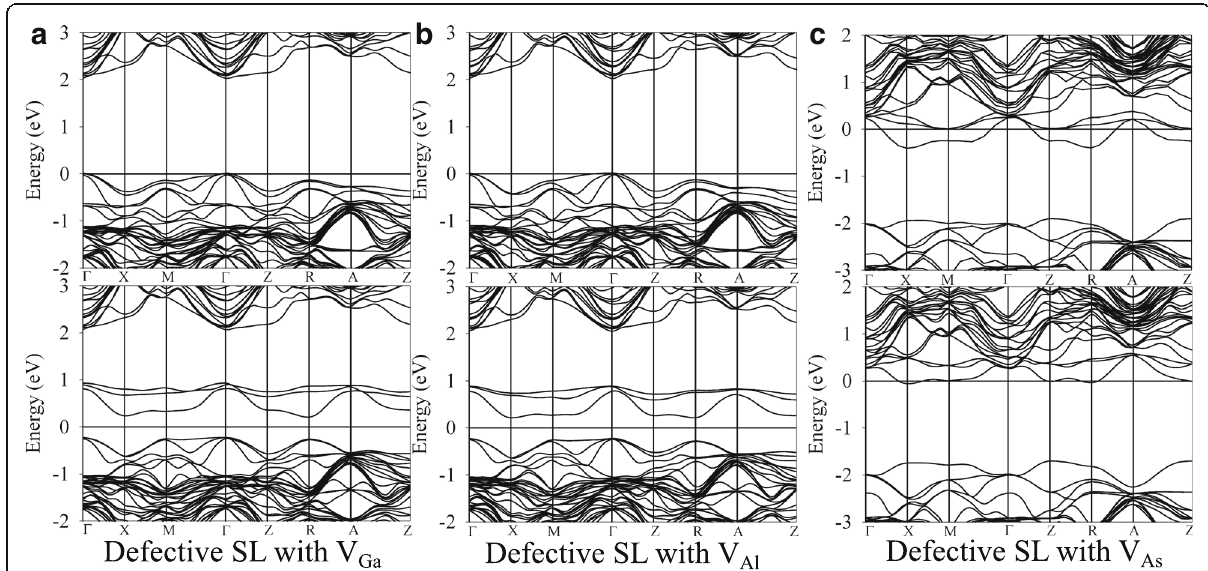
Fig. 7 The band structures of defective GaAs/AlAs superlattice with a V Ga , b V Al and c V As vacancy defects. V X (X = Ga, Al, or As) X vacancy